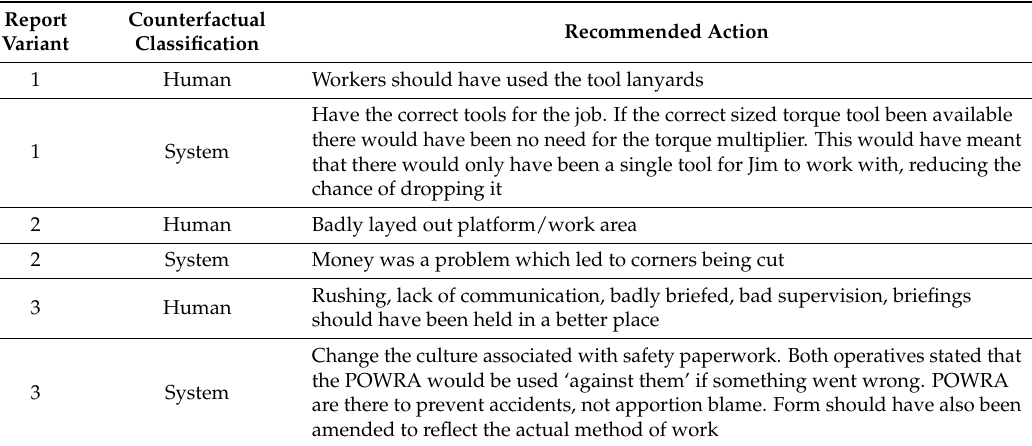
Table A3. Examples of counterfactual